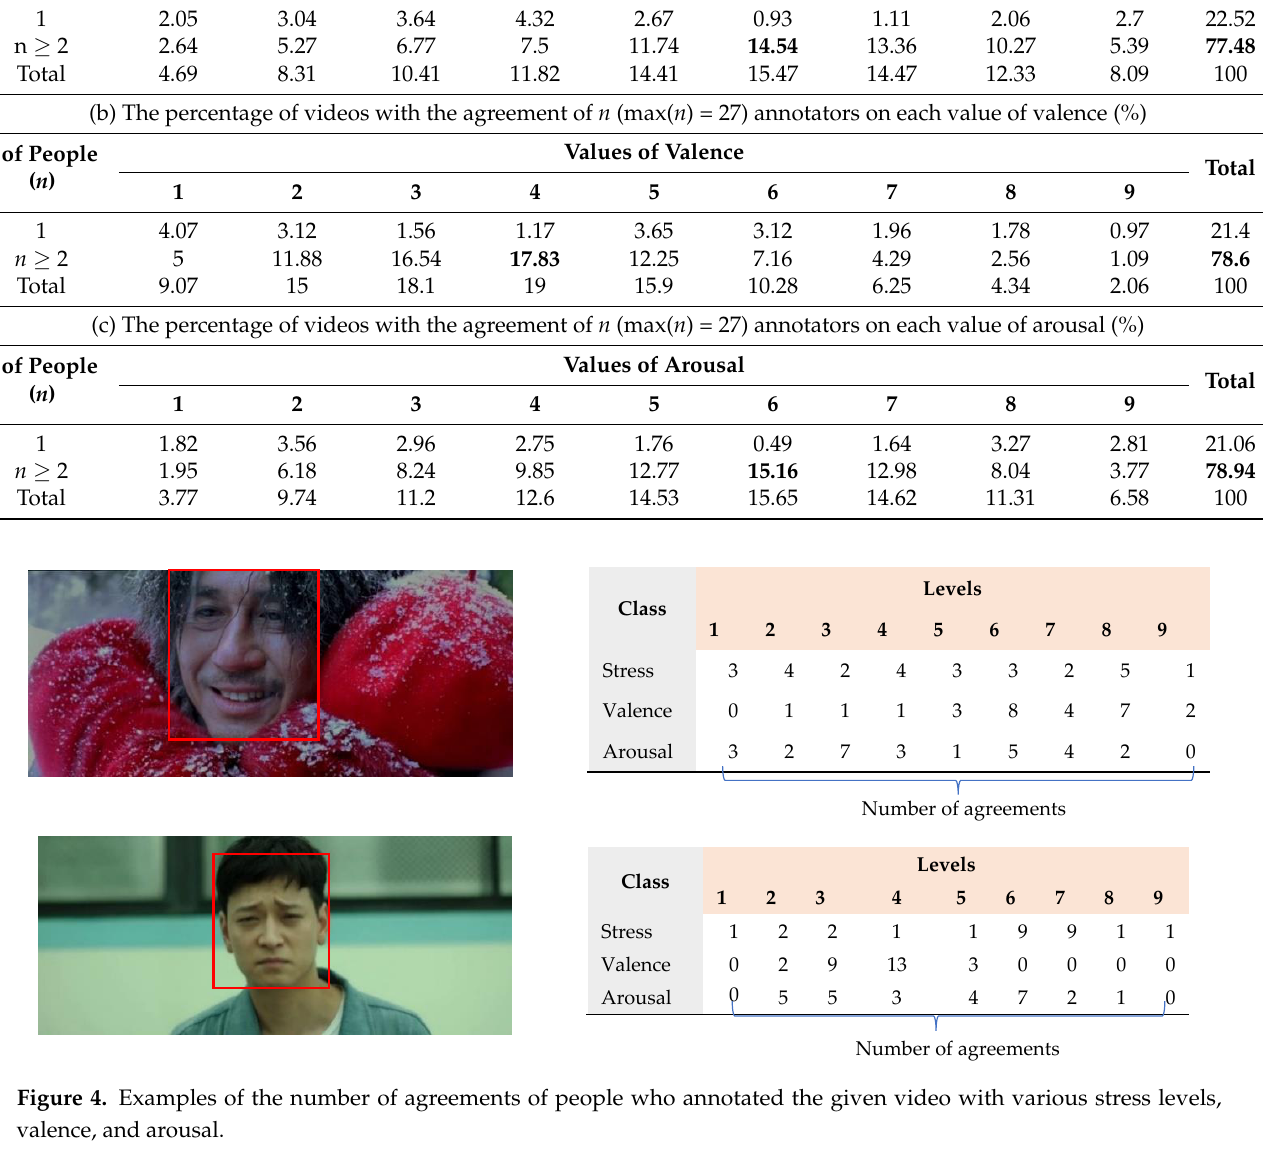
different levels of stress, valence, and arousal. For example, Figure 4 shows the number of people who annotated the given video with various levels of stress, valence, and arousal. Table 3. The percentage of videos with the agreement of n (max( n ) = 27) annotators on each value of stress, valence, and arousal. (a) The percentage of videos with the agreement of n (max( n ) = 27) annotators on each value of stress (%) Values of Stress